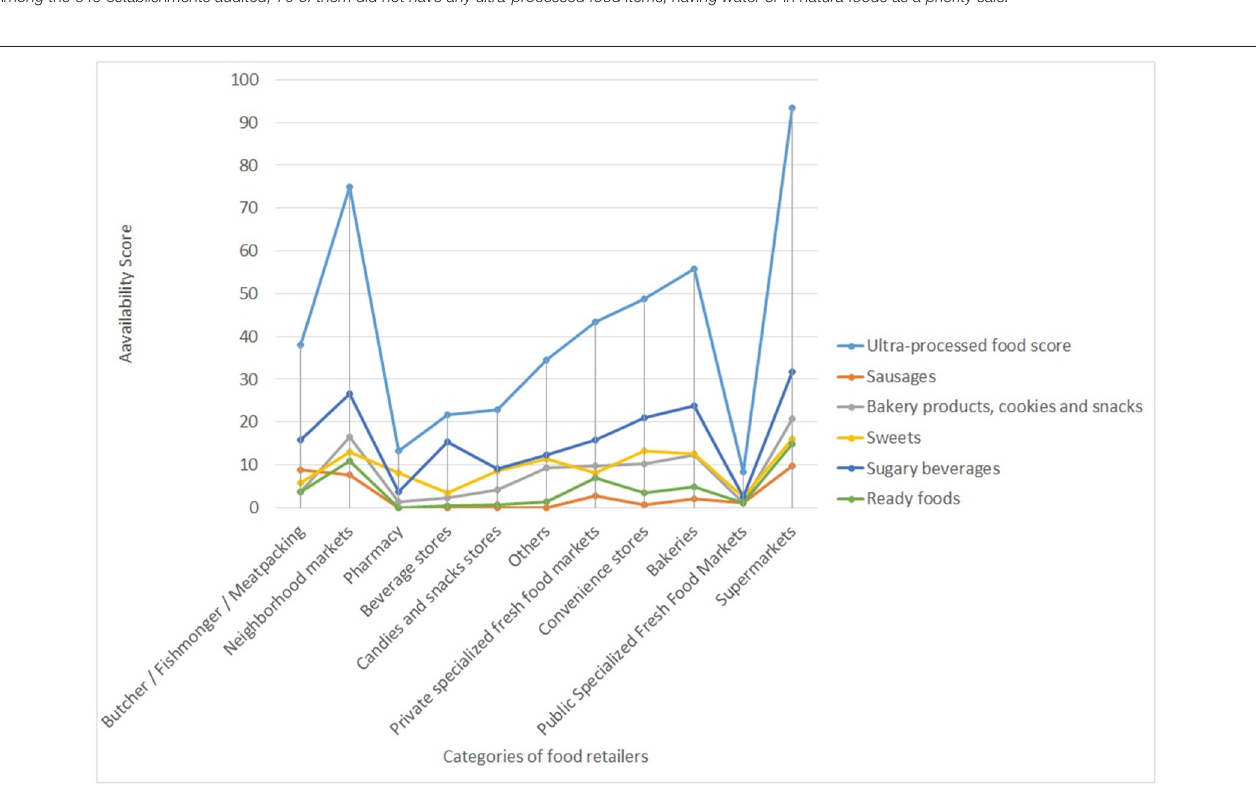
with low and middle income, a higher number of residents per household, and a higher percentage of people of color were associated with food retailers with the highest scores of ultra-processed foods. Mapping the score across the territory of the municipality made it possible to observe regions characterized as food deserts or food swamps according to the literature